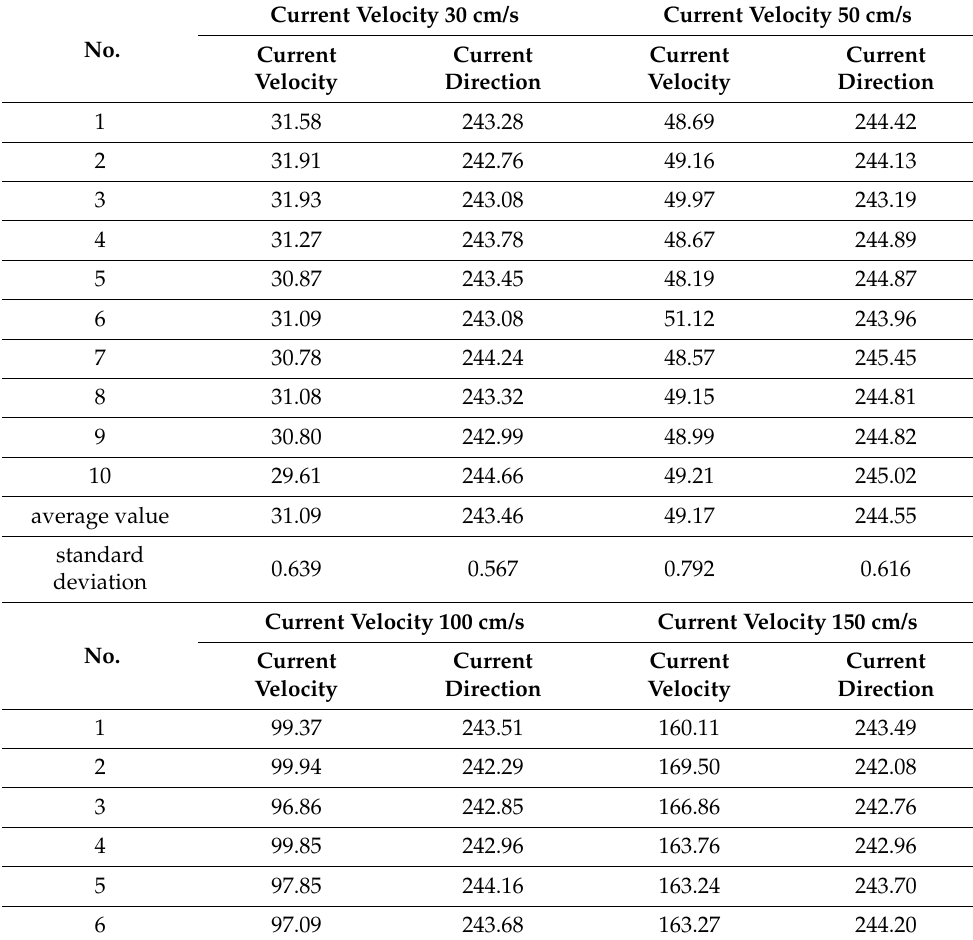
Table 2. Repeatability test of indoor running velocity (cm/s).